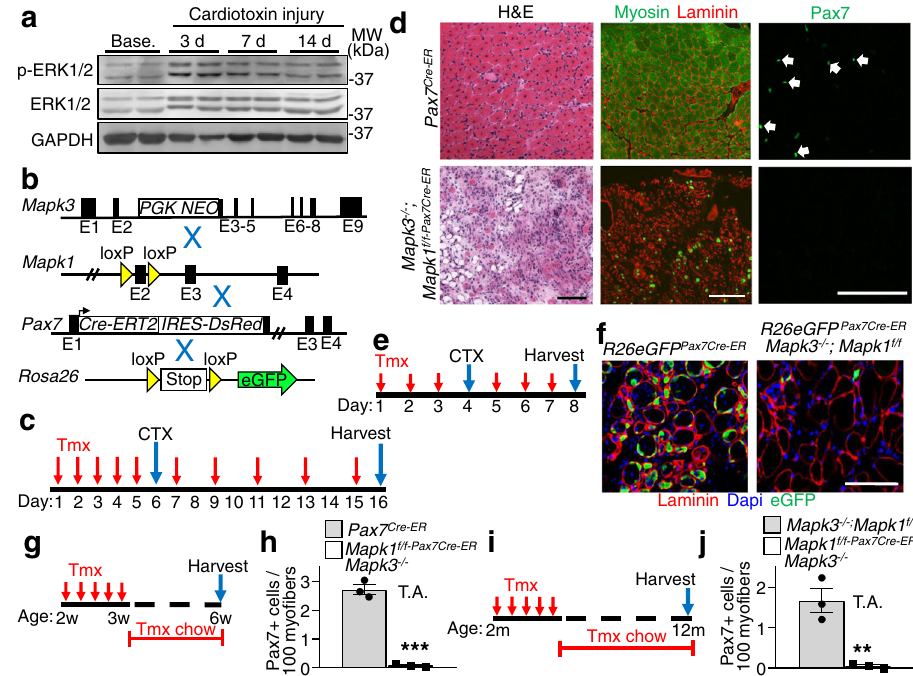
Fig. 1 Erk1/2 are required for satellite cell viability upon activation. a Western blot analysis for the indicated proteins using tibialis anterior (TA) lysate from samples taken at baseline (Base.) and following 3, 7 and 14 days (d) after cardiotoxin (CTX) administration. Results from two different mice are shown. b Schematic representation of breeding of Mapk3 − / − and Mapk1 -loxP(f)-targeted mice with the Pax7 Cre-ERT2 mouse as well as with the Cre- dependent R26eGFP reporter mouse. c Schematic showing the timing of tamoxifen (Tmx) and CTX treatments in 2-month-old mice. d Representative images of TA muscle sections from mice of the indicated genotypes stained with H&E (left panels), anti-myosin antibody (MF-20, green) and anti-laminin antibody (red, middle panels) or with anti-Pax7 antibody (green, right panels) 10 days post-CTX injury. Scale bars = 100 μ m. Samples from 3 different mice were analyzed. e Experimental scheme showing mice injected with Tmx for 3 days, then with CTX on day 4, followed by 3 more days of Tmx injections. f Representative histological sections showing eGFP fl uorescence (green) and immunostained for laminin (red) 4 days post-CTX injection in mice of the indicated genotypes. Nuclei are stained with Dapi (blue). Scale bar = 100 μ m. Samples from 3 different mice were analyzed. g Schematic representation of the Tmx treatment regimen. Two-week-old mice received Tmx injections for 5 consecutive days and were placed on Tmx chow after weaning. h Quanti fi cation of Pax7 + satellite cells from uninjured TA muscle sections from mice of the indicated genotypes. n = 3 mice per group. Signi fi cance was determined using a two-tailed Student ’ s t test, *** P < 0.001. i Schematic representation of Tmx treatment. Two-month-old mice received daily Tmx injection for 5 consecutive days and were subsequently placed on Tmx chow for 10 months. j Quanti fi cation of satellite cell numbers from uninjured TA muscle sections from 1-year-old mice of the indicated genotypes. n = 3 mice per group. Signi fi cance was determined using a two-tailed Student ’ s t test, ** P = 0.005. Data represent mean ± SEM for all